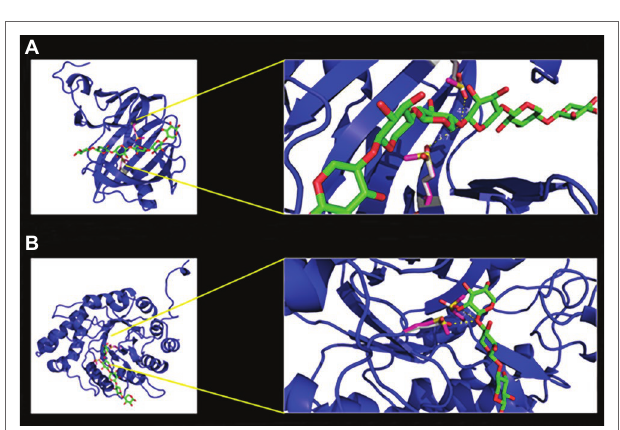
FIGURE 5 | Homology models of xylanase I (A) and xylanase II (B) with enlargement of the active center. The models were calculated with the program YASARA using the protein database PDB. The models were displayed with the program PyMol. The enzyme backbones are colored in blue, the xylooligosaccharides (XOS) carbon atoms in green, oxygen in red, active site residues glutamic acid carbon atoms in gray, methionine carbon atoms of the variants in pink, and in yellow is the sulfur.